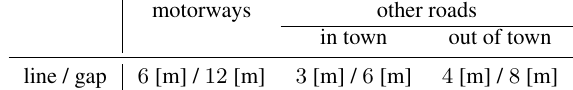
Table 1. Widths of lane markings